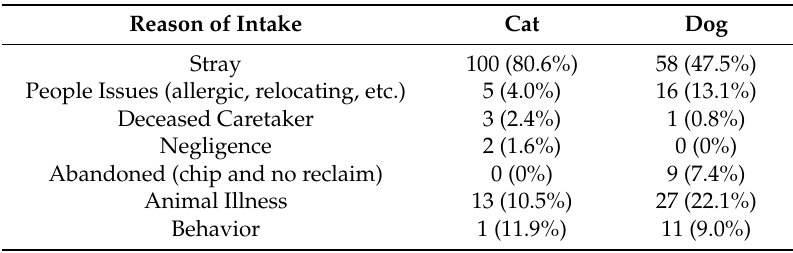
Table 2. Summary of reasons for intake at Austin Animal Center (AAC) for cats and dogs in the sample.